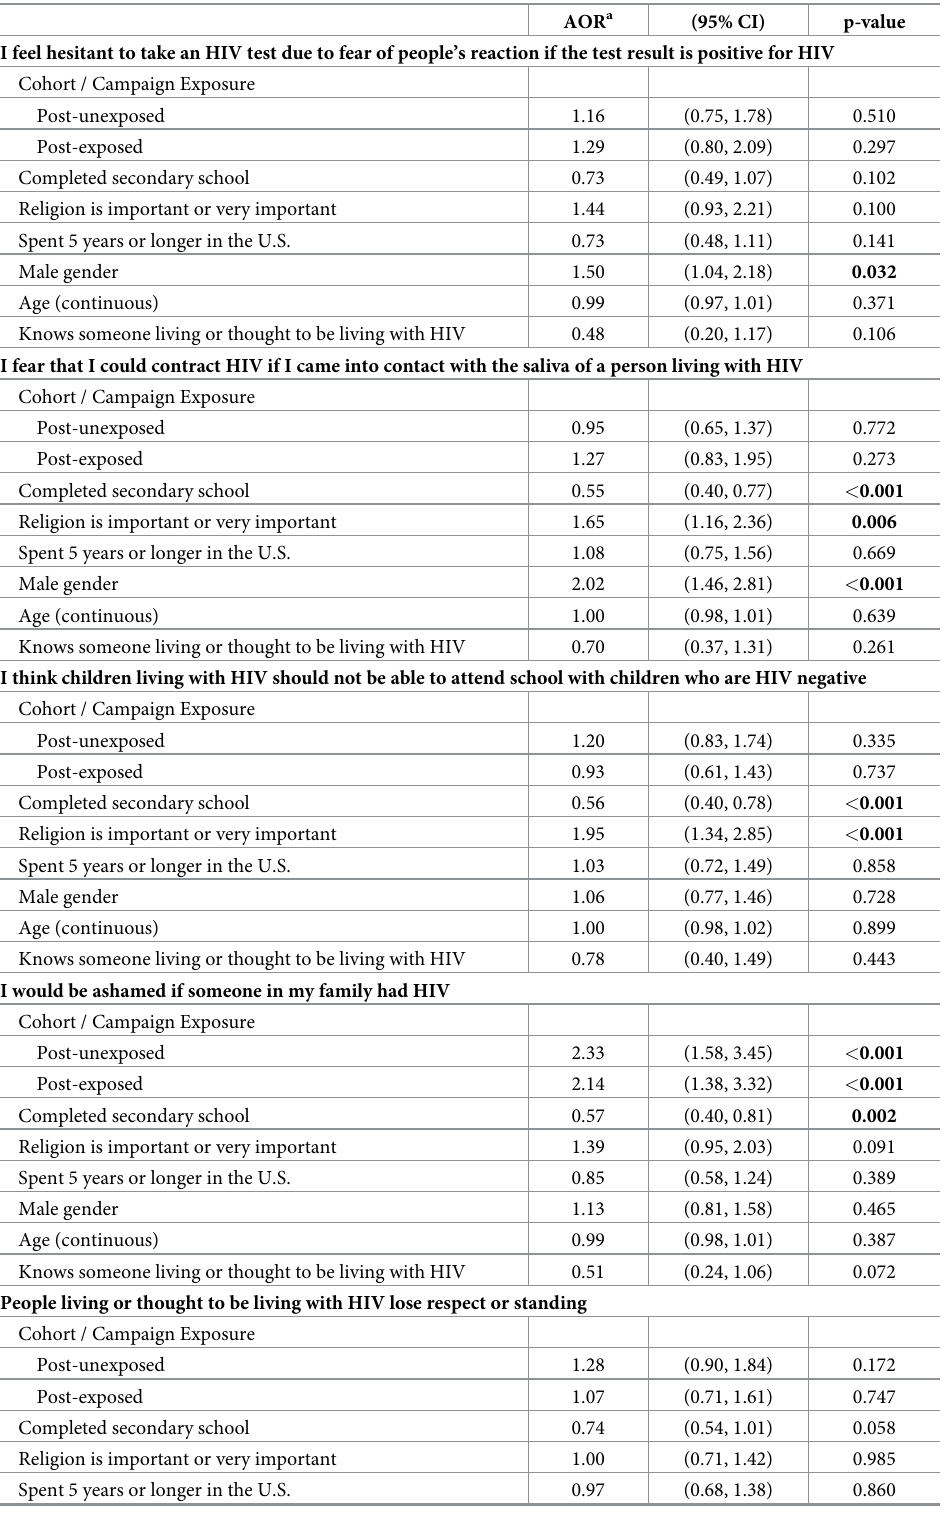
Table 3. Effects of cohort and Vive -campaign exposure on agreement with stigma